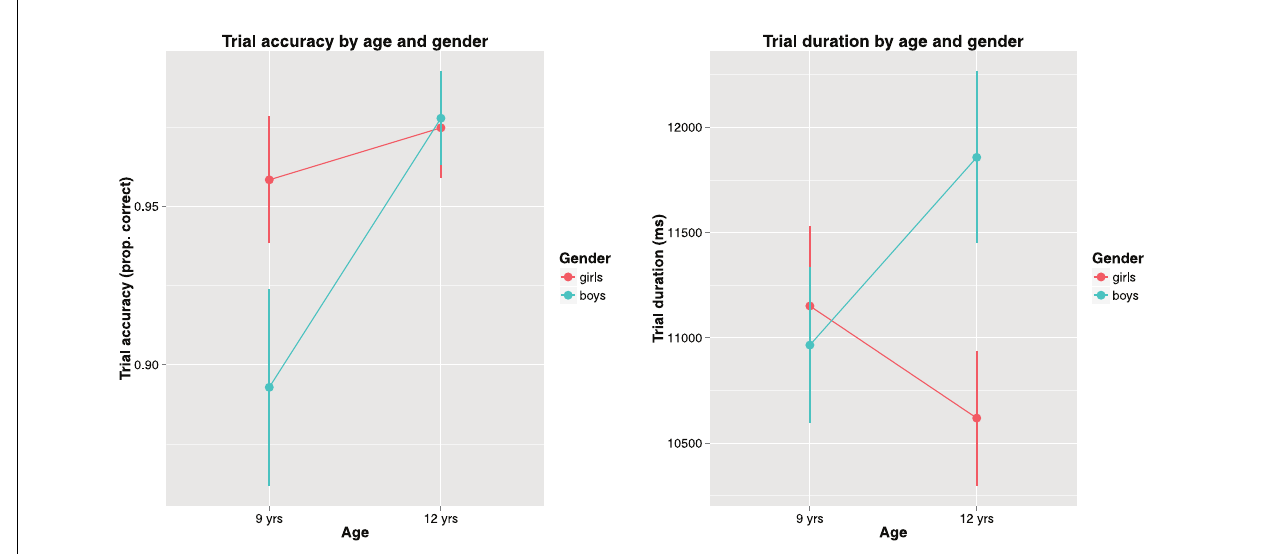
FIGURE 3 | Children’s age and gender plotted against trial accuracy (left) and trial duration (right).